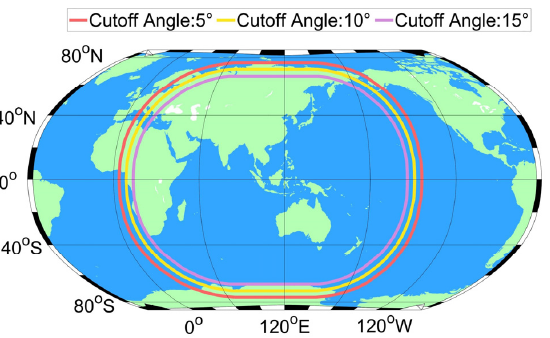
Figure 1. The Earth coverage areas of the three GEO satellites for 5°, 10°, and 15° elevation cut-off angles.